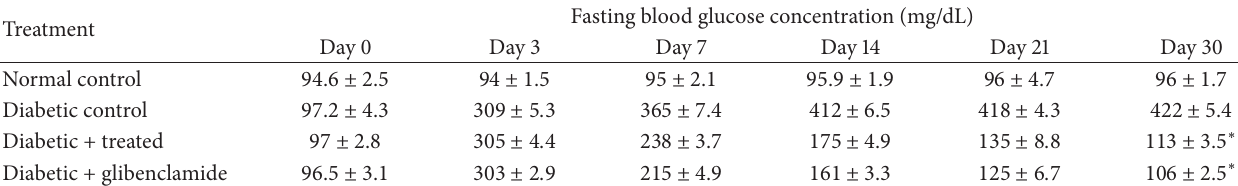
Table 4: Effect of Triticum aestivum on the urine glucose level in streptozotocin-induced diabetic rats. Treatment Normal control Nil Diabetic control Diabetic + glibenclamide